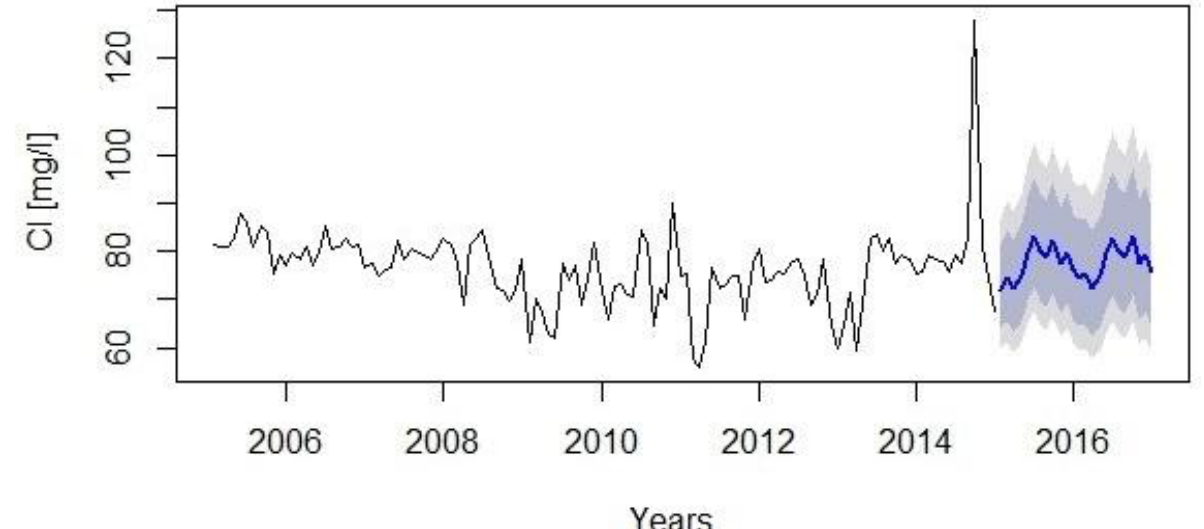
Fig. 8. Forecast of the changes in chloride content in the period from February 2015 to February 2017 using the SARIMA